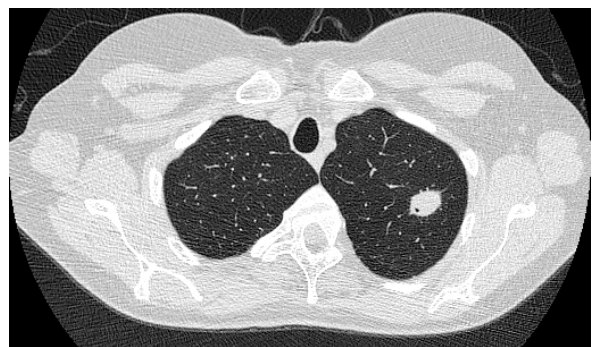
Figure 5. Aspergillus nodule—CT scan from a patient with an isolated pulmonary nodule attributable to Aspergillus spp., unusually this lesion is showing signs of early cavitation.